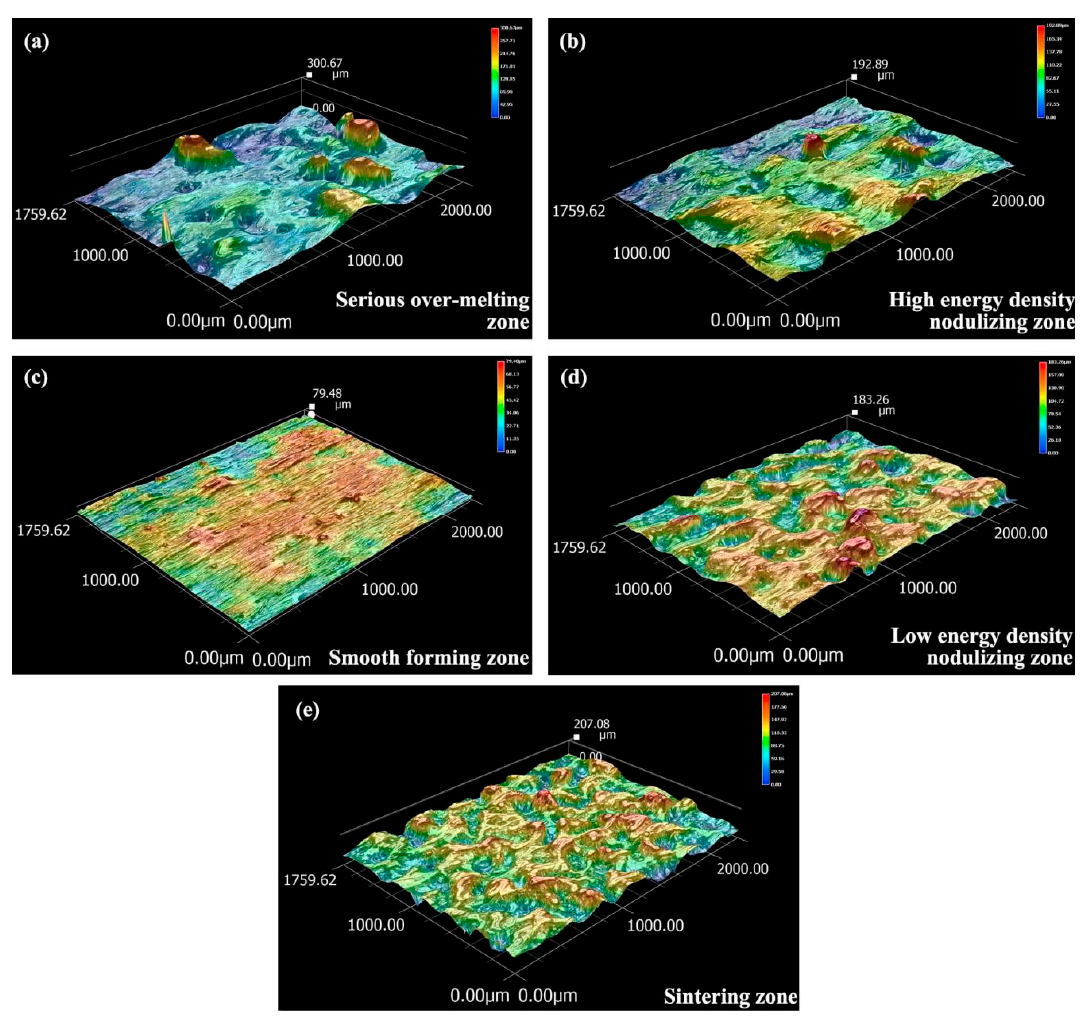
Figure 4. 3D surface morphologies of five forming zones: ( a ) serious over-melting zone; ( b ) high-energy density nodulizing zone; ( c ) smooth forming zone; ( d ) low-energy density nodulizing zone; ( e ) sintering zone.